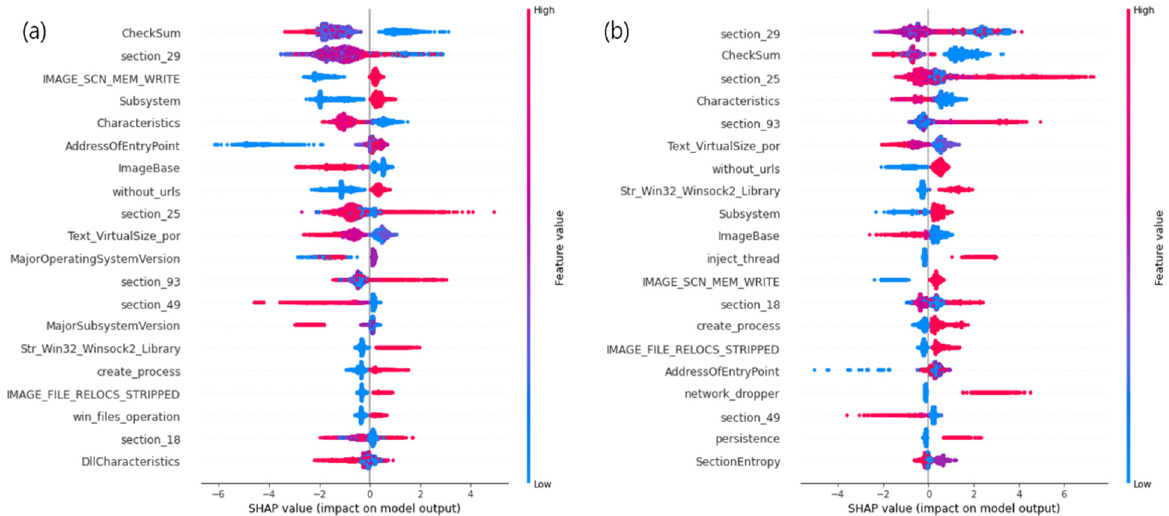
Figure 8. Summary plots by label in the training dataset: ( a ) instances labeled normal in the training dataset; ( b ) instances labeled attack in the training dataset.